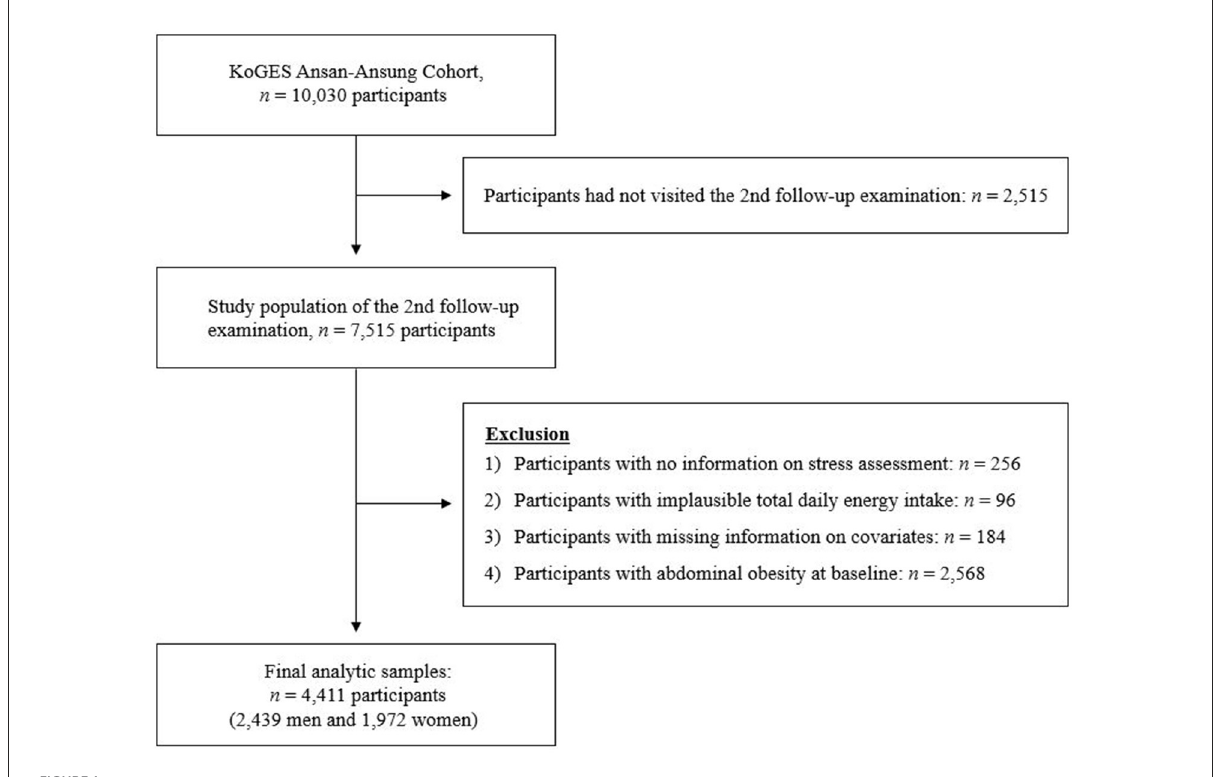
FIGURE1 Flow diagram of the study